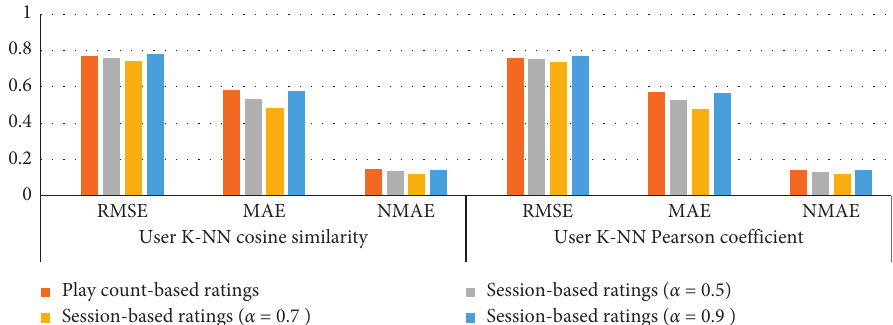
Figure 1: Error rates given by the user K-NN algorithm with two similarity metrics for the ratings computed in four different ways.